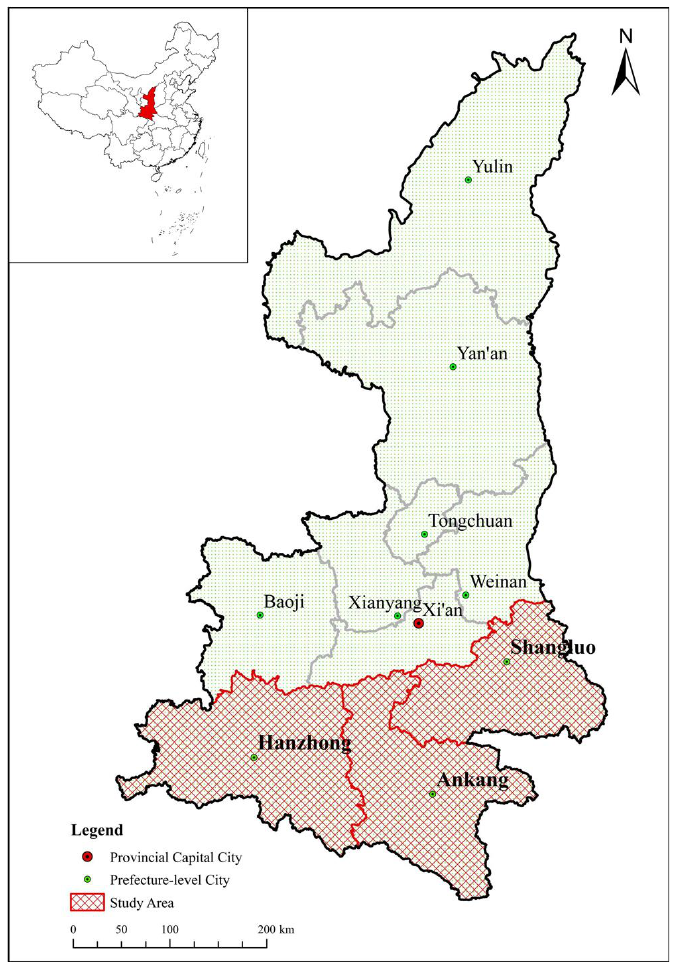
Figure 1. Location of research